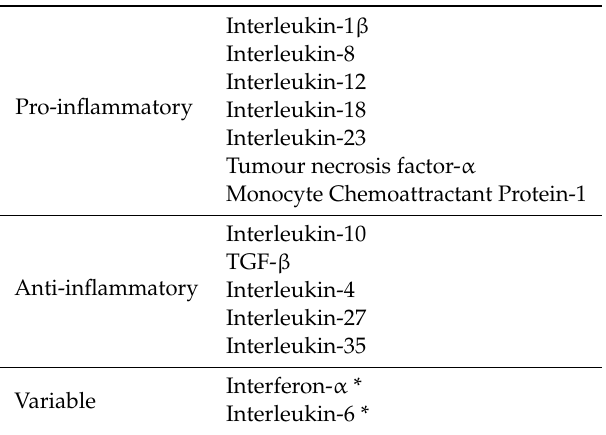
Table 1. The inflammatory nature of cytokines